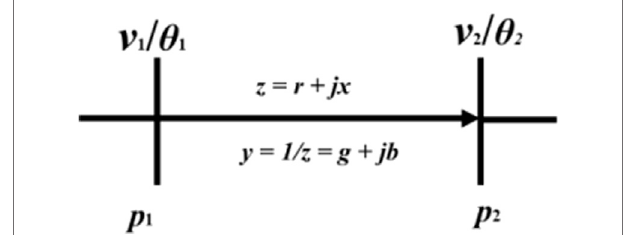
FIGURE A1 | AC transmission line model.